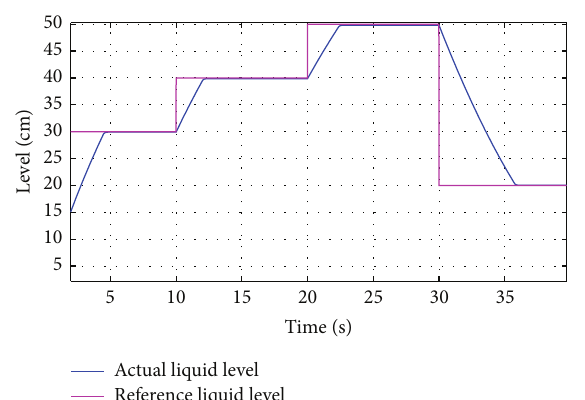
Figure 7: A view of the oscilloscope screen without optimization (level set: 30, 40, 50cm).